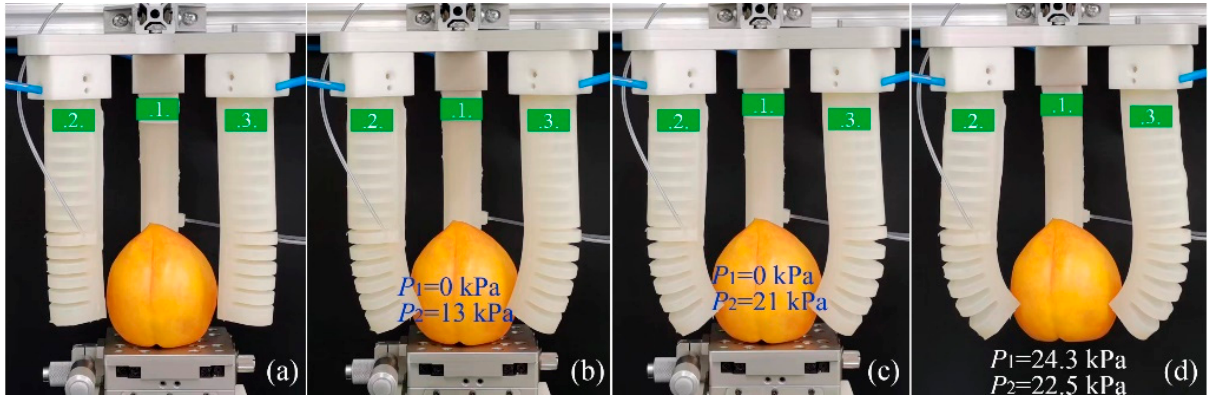
Figure 17. Primary stages of an EG grasping process: ( a ) the original state, ( b ) soft actuators first get in touch with the sphere, ( c ) forming an enveloping grasp with the increase in pressure, and ( d ) realization of a stable PG with line contact.